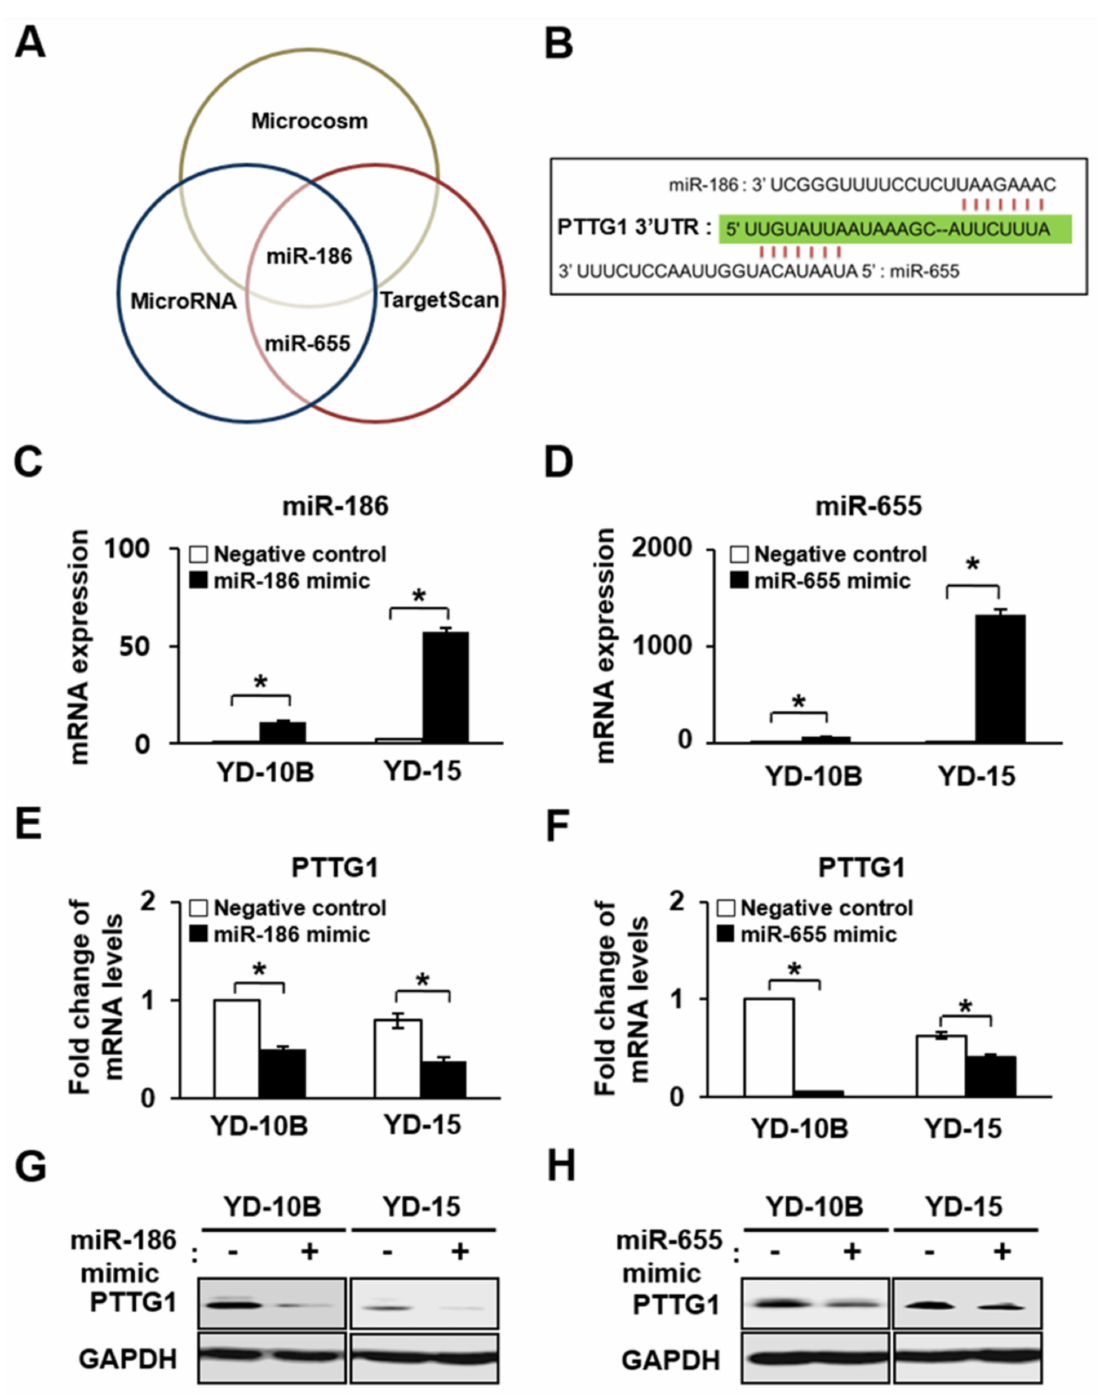
Figure 4. Effect of up-regulated of miR-186 and -655 on PTTG1 expression in oral SCC celllines. ( A ) Venn diagram showing overlapping miRNAs related to PTTG1 mRNA by Microcosm, Micro RNA, and Target Scan. ( B ) miRNA sequence and target of the PTTG1 gene in the 3 (cid:48) -UTR site. Expression of ( C ) miR-186 and ( D ) miR-655 determined by qRT-PCR in YD-10B and YD-15 cells treated with mimic sequences. mRNA expression of PTTG1 determined by qRT-PCR in YD-10B and YD-15 cells treated with ( E ) miR-186 and ( F ) miR-655 mimic sequence. * indicates significant differences between Negative control and mimic treatment ( p < 0.05). All experiments were performed in triplicate. Protein expression of PTTG1 determined by Western blots in YD-10B and YD-15 cells treated with ( G ) miR-186 and ( H ) miR-655 mimic sequence. GAPDH was used as an internal